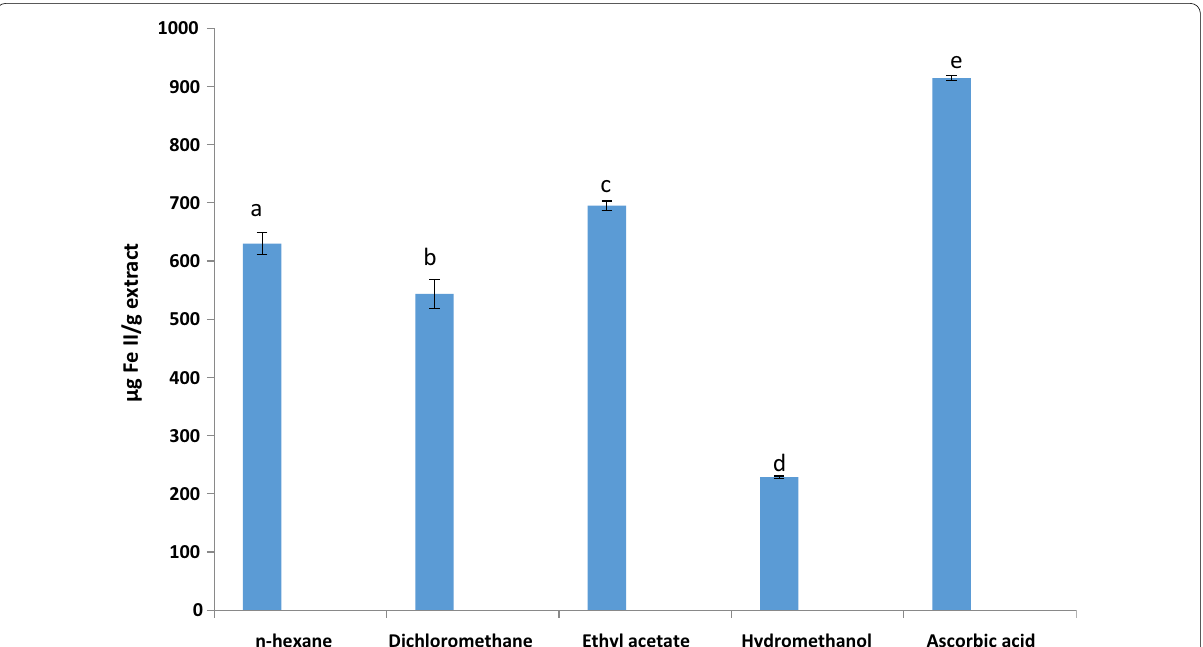
Fig. 5 Ferric reducing antioxidant potential (FRAP) of fractions from leaf extract of C. albidum. Values are expressed as mean alphabets on bars show that values for the fractions are significantly different ( p < 0.05) from each other. The ethyl acetate fraction from leaf extract of C. albidum had significantly higher ( p < 0.05) FRAP value in comparison with the other fractions. However, ascorbic acid standard had significantly higher ( p < 0.05) FRAP value than ethyl acetate fraction